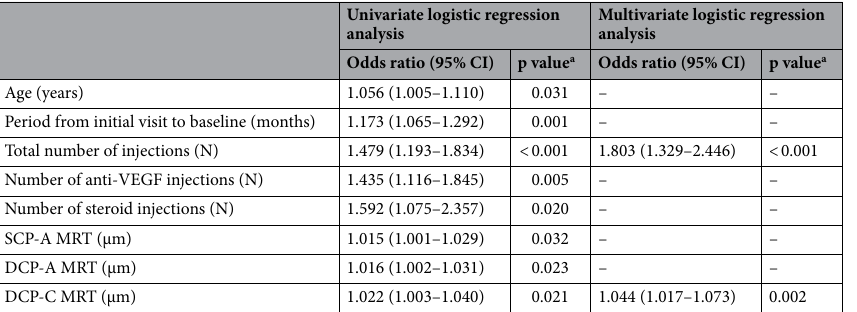
Univariate logistic regression